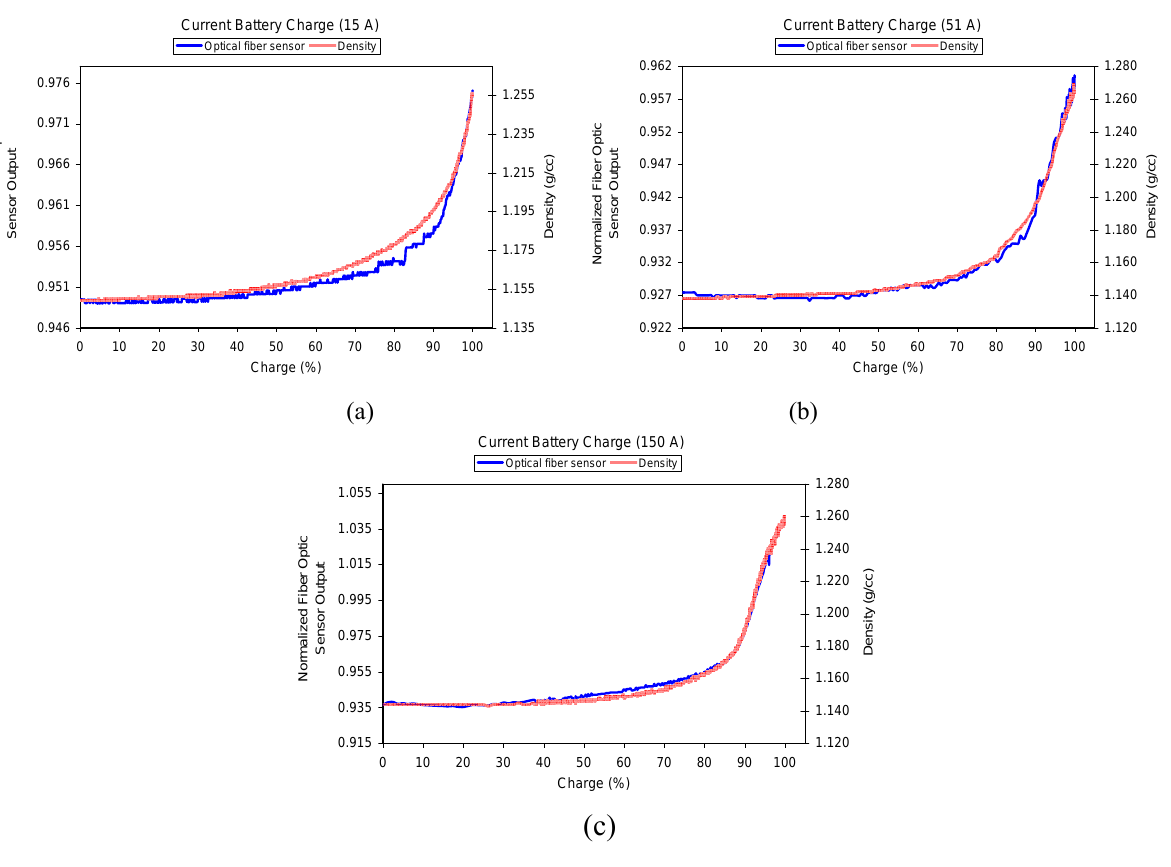
Figure 13. Measurement of the density of the electrolyte during the battery charging process taken by the optical fiber sensor (normalized values) and using the YUASA sensor YPG-201 (gr/cc). (a) Charge 15 A, (b) Charge 51 A. (c) Charge 150 A. Current Battery Charge (15 A)